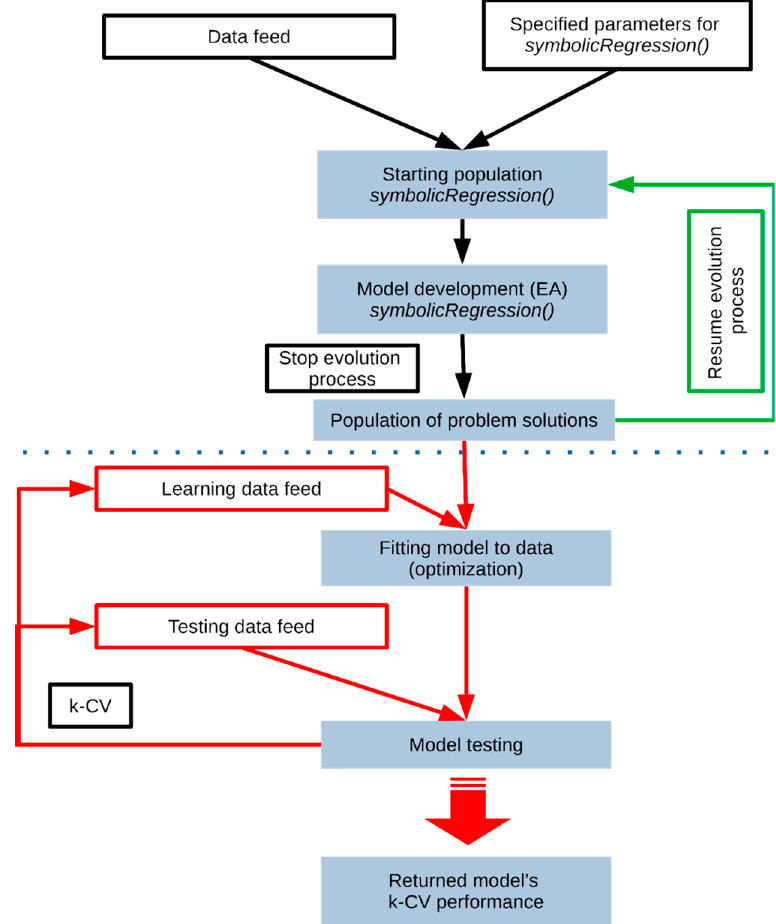
Figure 2. The workflow of in-house developed software implementing rgp framework to model development and assessment system using genetic programming methods. The first stage is based on a symbolic regression function allowing the development of formal mathematical equation fitting defined data. Later, the process is stopped, models are tested according to the k-fold cross-validation (k-CV) scheme, and the evolution process is resumed. Parameters affecting the evolutionary algorithms and model development process can be modified in the text user interface [19].